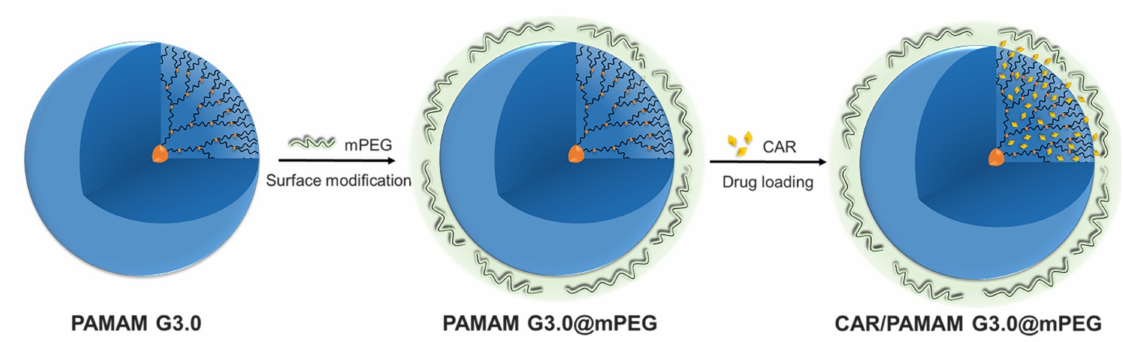
Figure 1. Illustration showing the surface modification of low generation polyamidoamine G3.0 dendrimer (PAMAM G3.0) with methoxypolyethylene glycol (mPEG) and the loading of carboplatin (CAR) into PAMAM G3.0@mPEG to form CAR / PAMAM